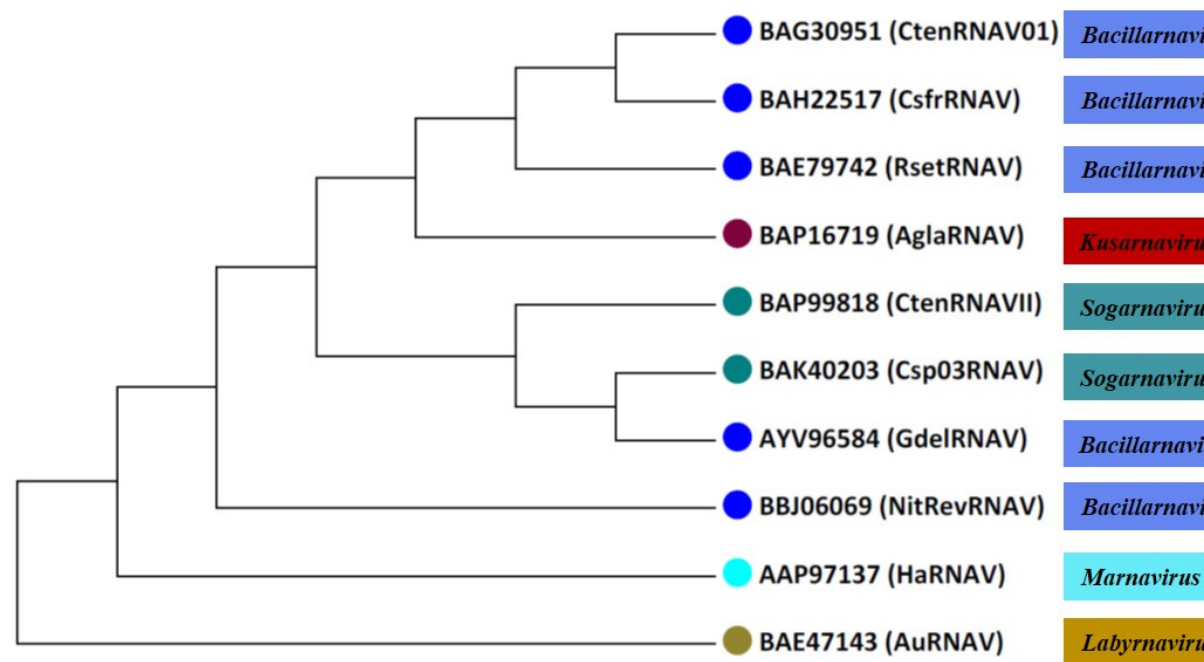
Figure 2. Comparative phylogenetic analysis of eight diatom viruses based on complete RNA sequences. This phylogenetic tree was constructed using the maximum likelihood (ML) method with the MEGA 7.0 software. RsetRNAV: Rhizosolenia setigera RNA virus; CsfrRNAV: Chaetoceros socialis f. radians RNA virus; CtenRNAV Type 1: Chaetoceros tenuissimus RNA virus Type I; CtenRNAV Type 2: Chaetoceros tenuissimus RNA virus Type II; Csp03RNAV: Chaetoceros sp. strain SS08-C03 RNA virus; GdelRNAV: Guinardia delicatula RNA virus; AglaRNAV: Asterionellopsis glacialis RNA virus; NitRevRNAV: Nitzschia reversa RNA virus; HaRNAV: Heterosigma akashiwo RNA virus; AuANAV: Aurantiochytrium ssRNA virus. Illustration by